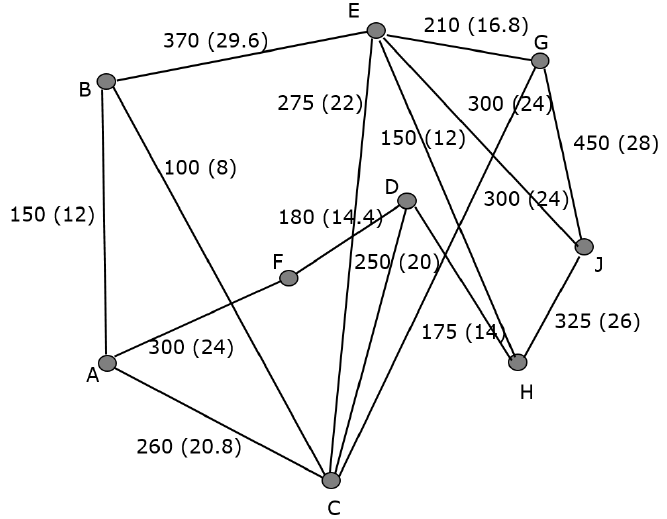
Figure 6. Graphical representation of the nondirected weighted graph G whose weights denote the kilometers between cities (and the corresponding fuel cost in EUR between